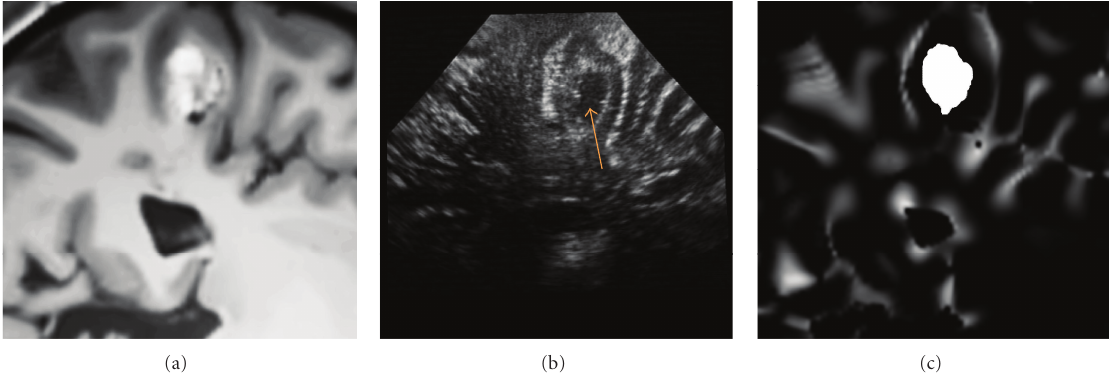
Figure 2: Patient 1. (a) The denoised MR image corresponding to US image (b). (c) The probability map based on MLvv operator and extracted from denoising MR image. The preoperative MR image is resliced with the registration matrix provided by the neuronavigation system. The matching is not perfect due to the initial error, estimated around 4 . 2mm by the experts for this patient. As visible on the US image, the lesion presents a hypoechogenic central area (indicated on the US image by a